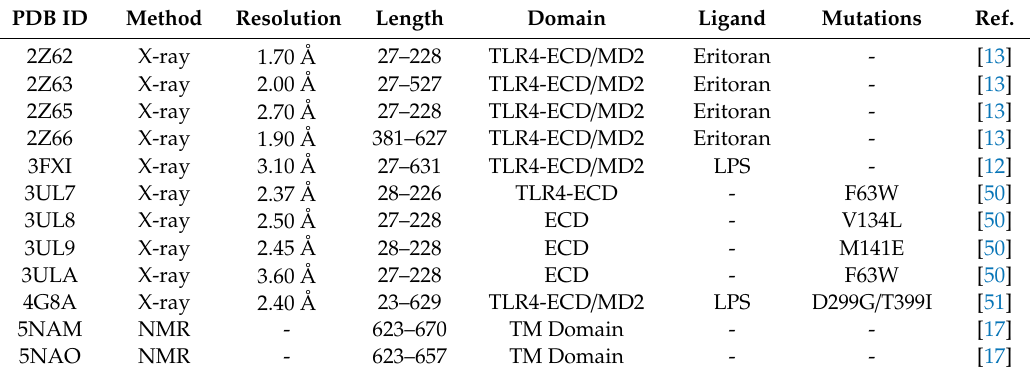
Table 1. 3D structures of human TLR4 domains available in